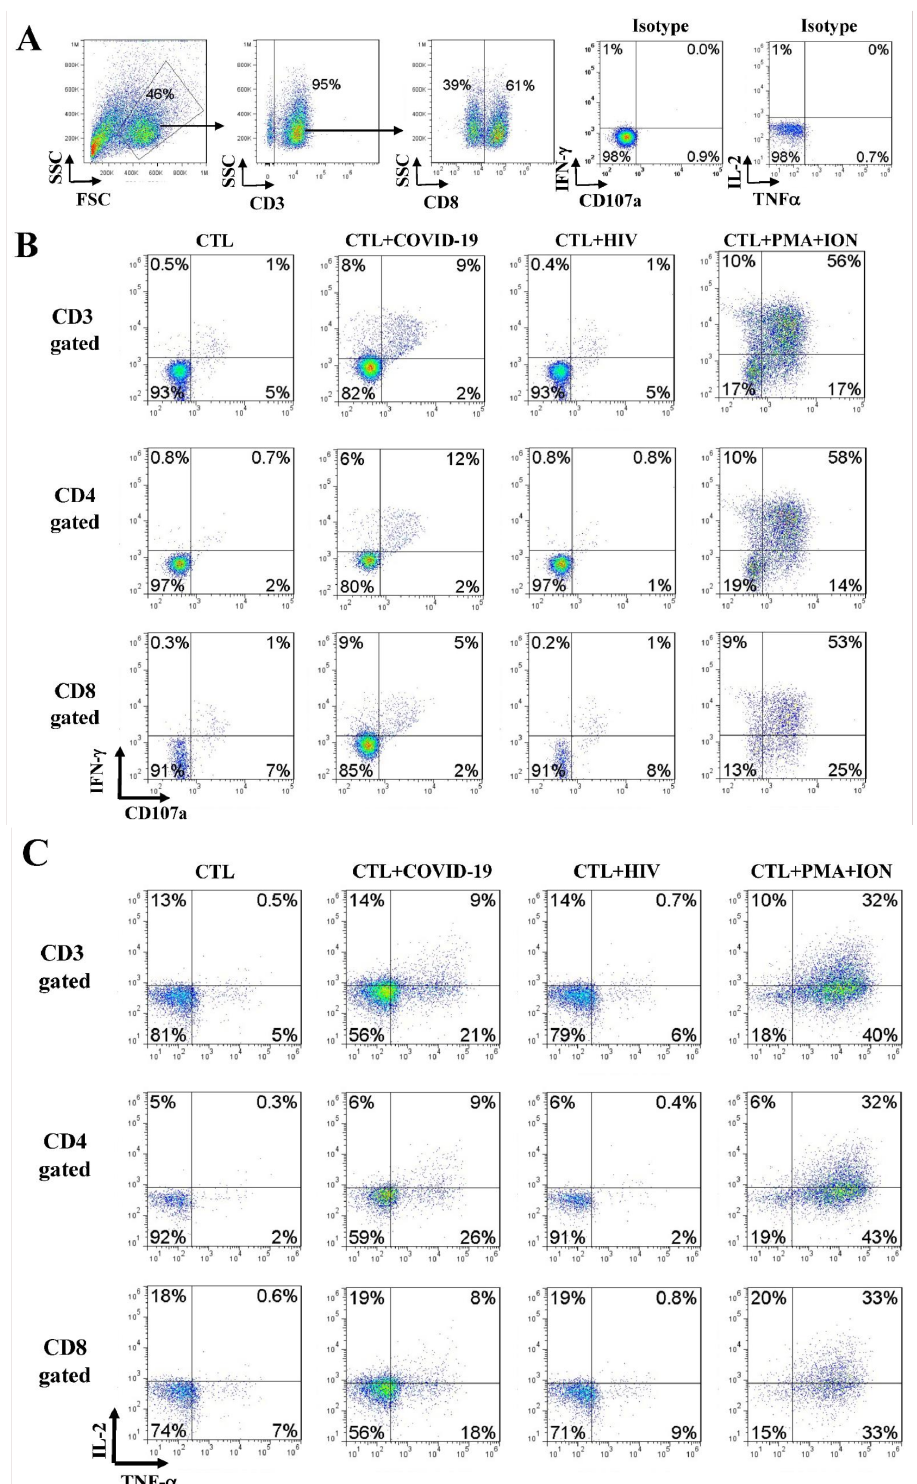
Figure 5. Effector function analyses of T cells against SARS-CoV-2 SEMNP antigens. After DC–T-cell coculture, the viral antigen-specific CTLs were analyzed for cytokine release and CD107a degranulation by intracellular staining and flow cytometry. The TNF- α , IFN- γ , IL-2, and CD107a production in T cells were illustrated in the FACS graphs after stimulations with SARS-CoV-2 antigenic peptides. PMA and ionomycin (PMA + ION) activation served as positive control, and